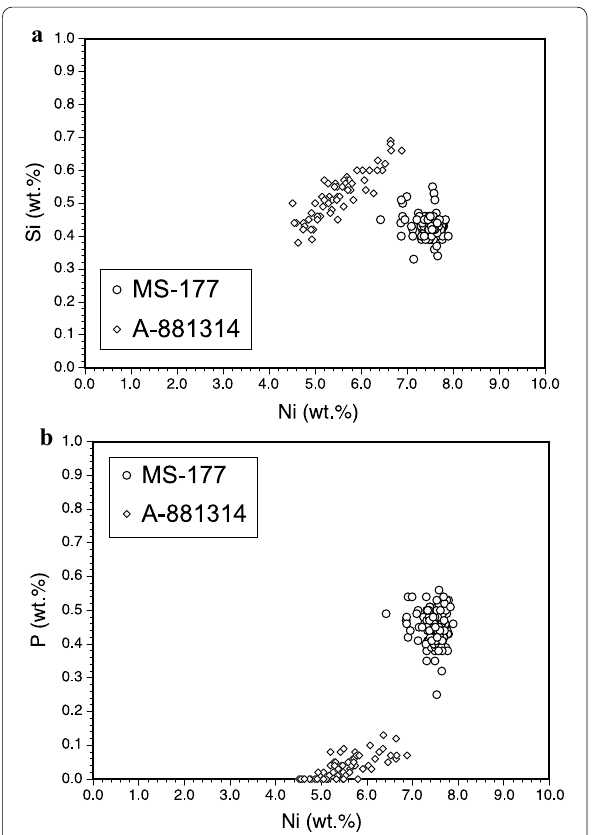
Fig. 3 Compositions of Fe–Ni metal in MS-177 and A-881314 on a Ni versus Si plot, and b Ni versus P plot